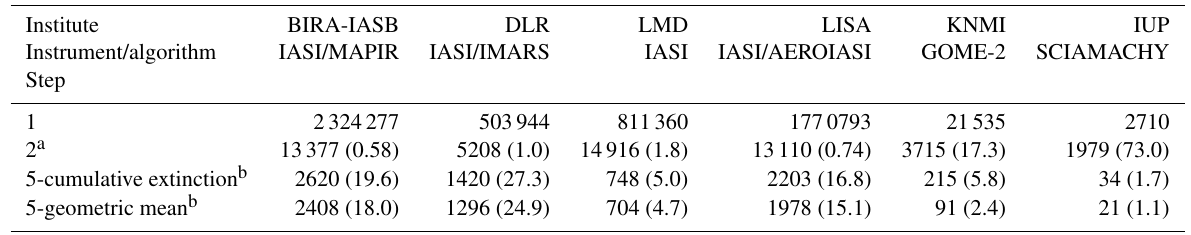
Table 2. The number of data points (dust heights) at the data reducing step of the data analysis chain described in Sect. 2.3. Step number refers to the analysis steps as described in Sect. 2.3.